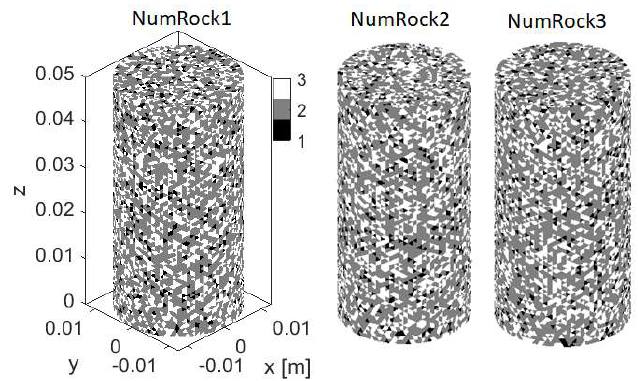
Figure 3. Numerical granite samples (Quartz = 3, Feldspar = 2, Biotite = 3). With respect to temperature dependence of the rock properties, a simplified ap- proach is adopted. Accordingly, only the thermal expansion is taken as temperature de- pendent. The experimental setting is as follows: First, the specimen is heated slowly to the desired temperature. Then, it is left to cool down to room temperature. The uniaxial ten- sion test is finally carried out at the room temperature. This thermal pre-treatment gener- ates cracks into the sample causing reduction of its tensile strength.